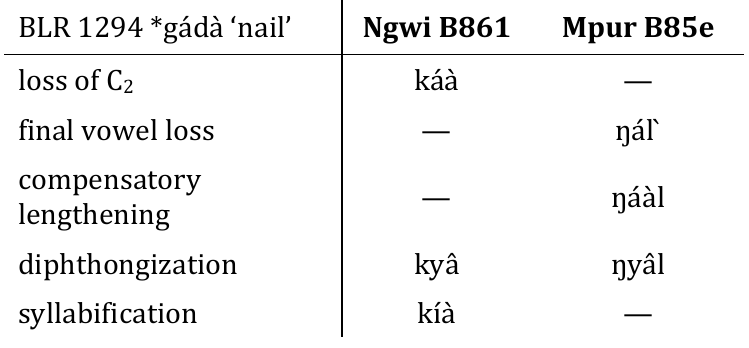
Table 6 : Possible chronology for i.a and ya outcomes in Lower Kasai